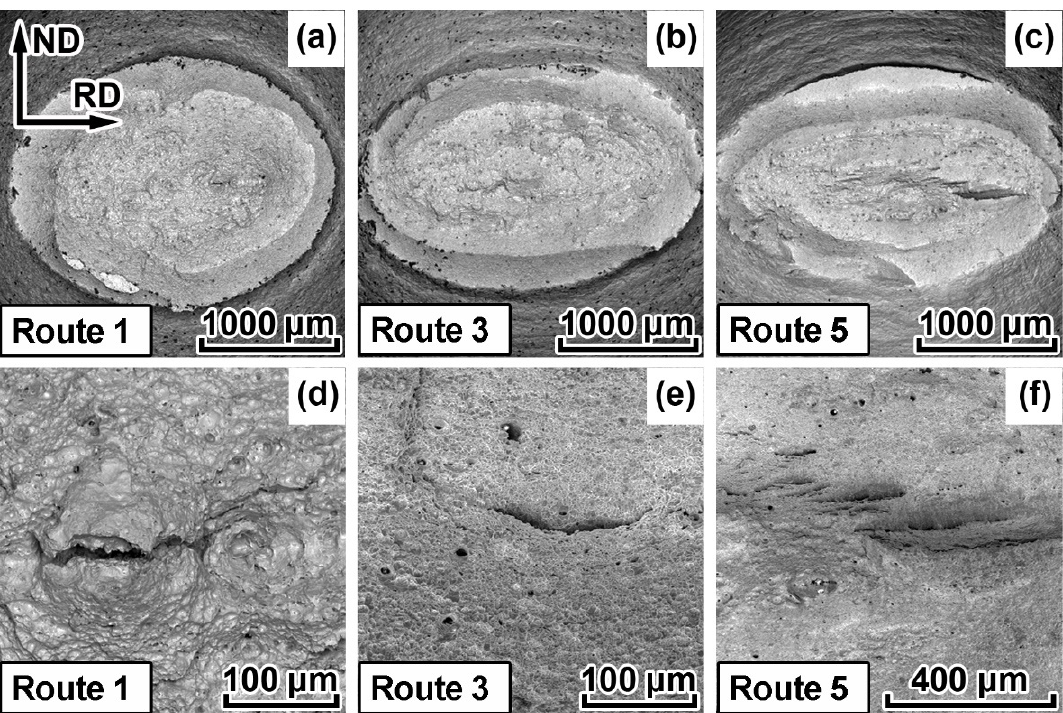
Figure 8. Fracture surfaces of cylindrical specimens of pipeline steel after standard tensile testing: ( a , d ) route 1; ( b , e ) route 3; ( c , f ) route 5.